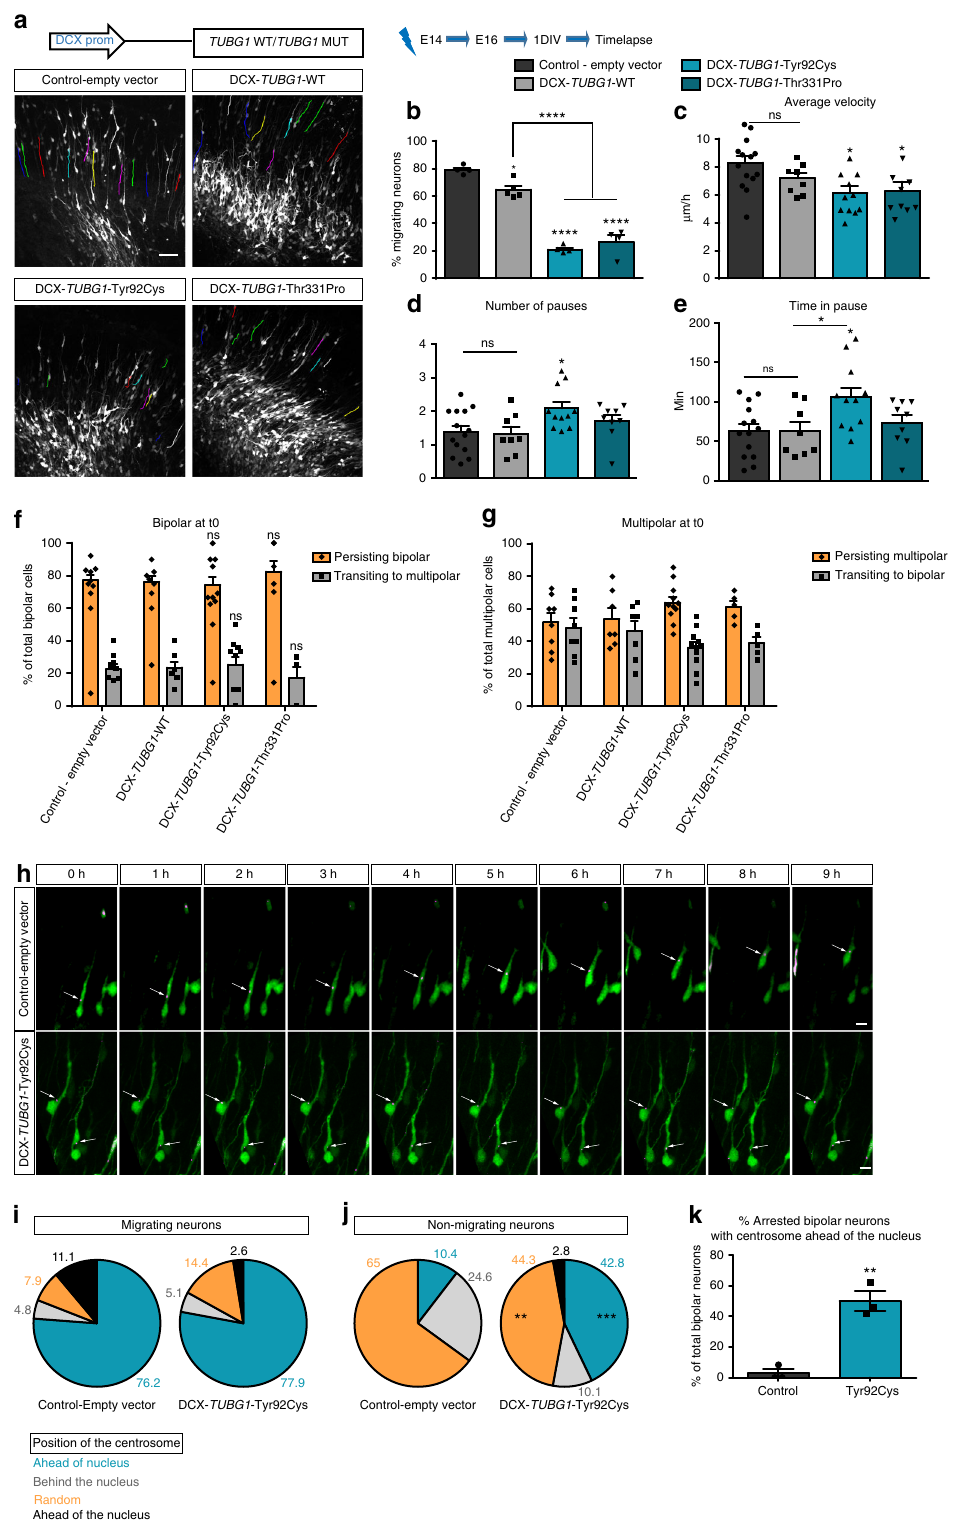
Ahead of nucleus Behind the nucleus Random Ahead of the nucleus then behind/random